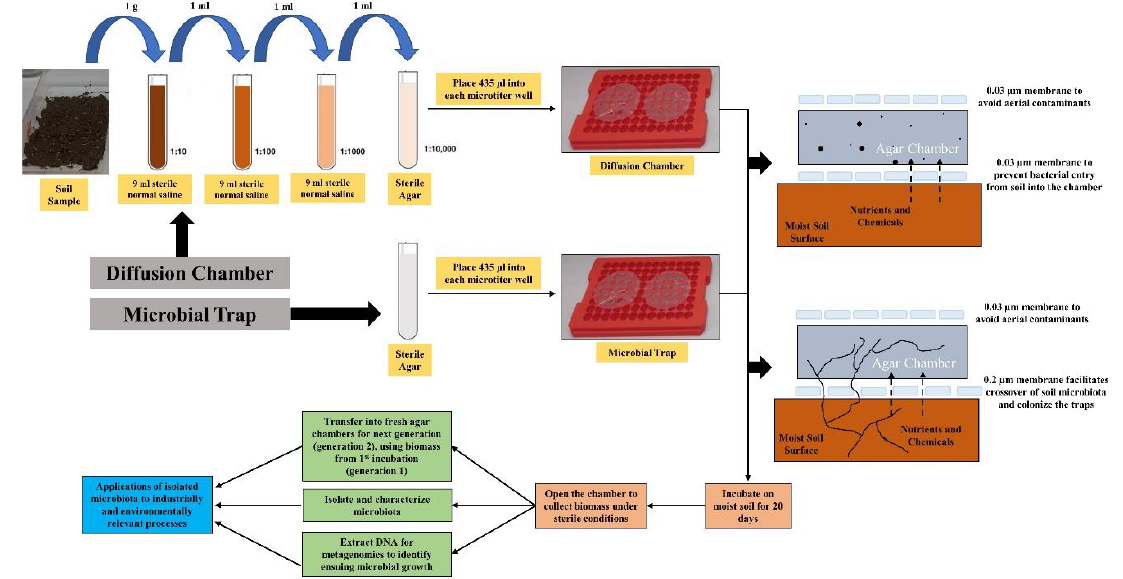
Figure 1. Overall schematic of experimental design to establish the DC/MT chambers.